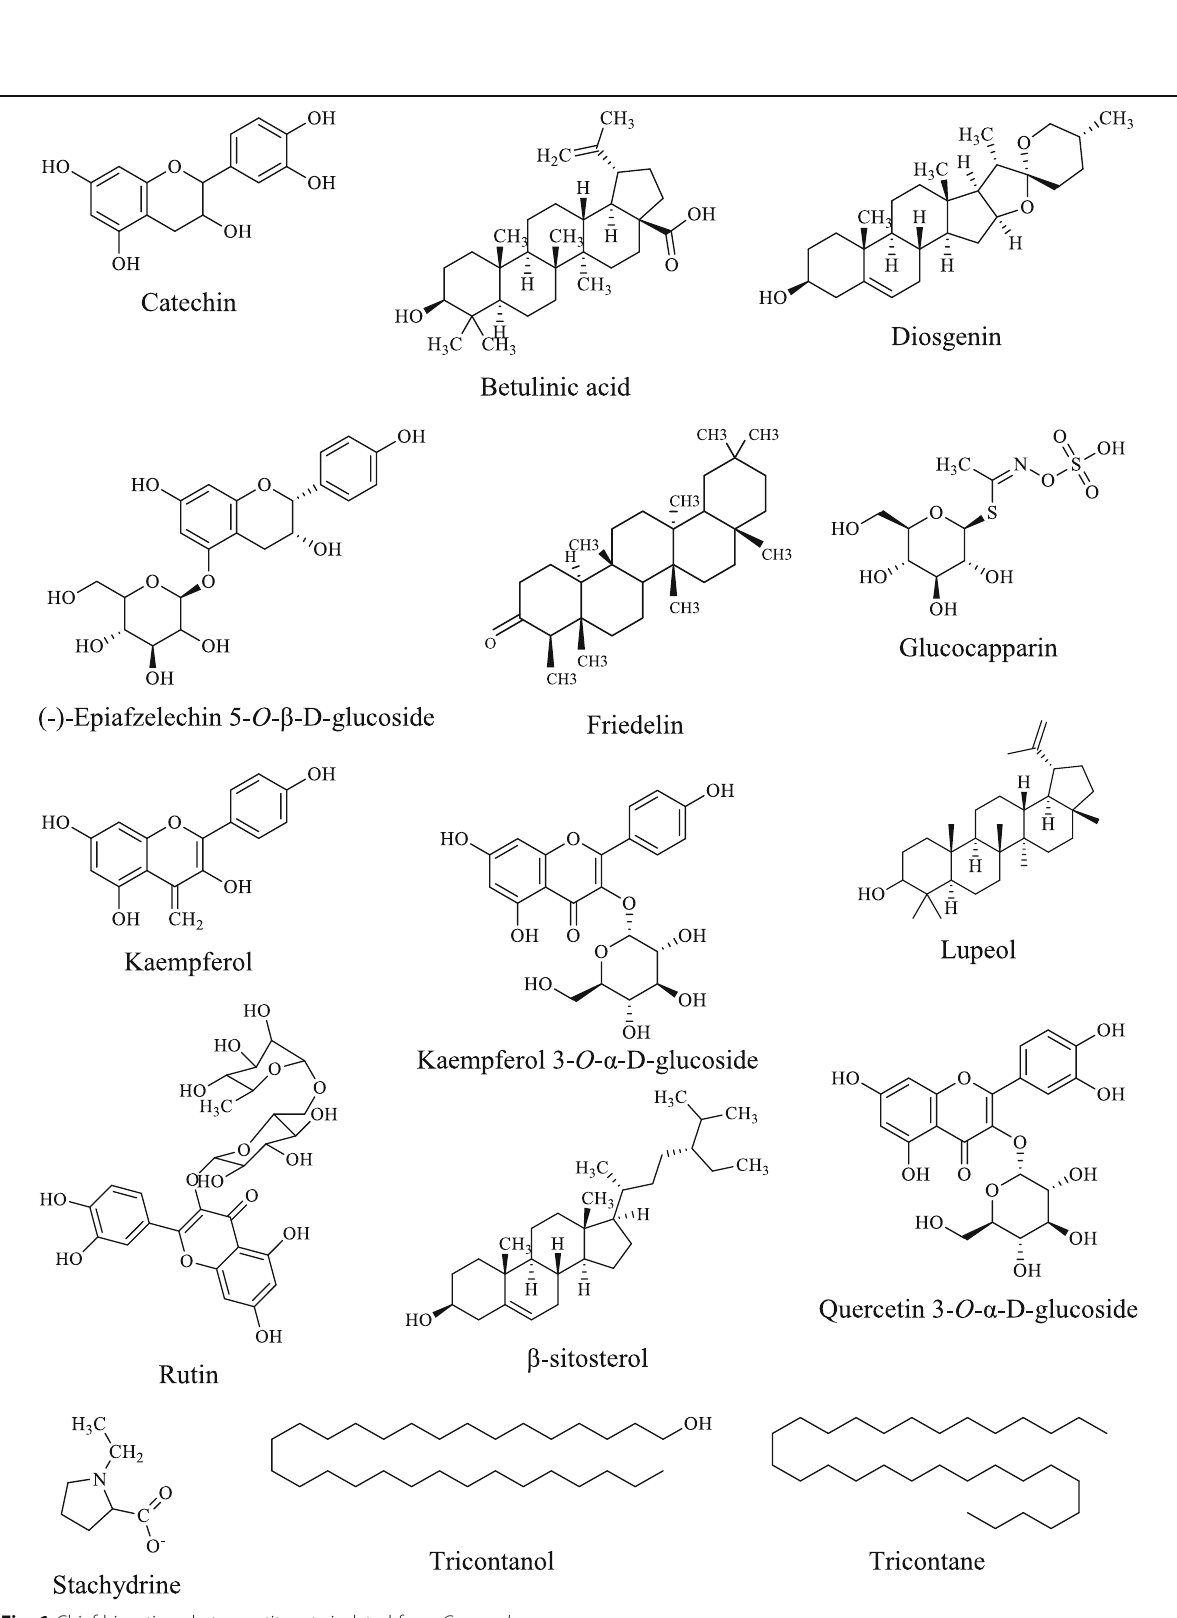
Fig. 1 Chief bioactive phytoconstituents isolated from C .